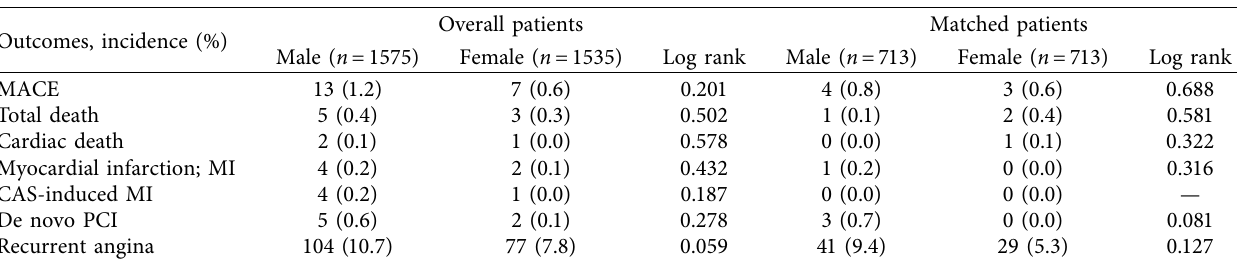
Table 4: Various clinical outcomes of coronary artery spasm up to 5-year by Kaplan–Meier curve analysis. Outcomes, incidence